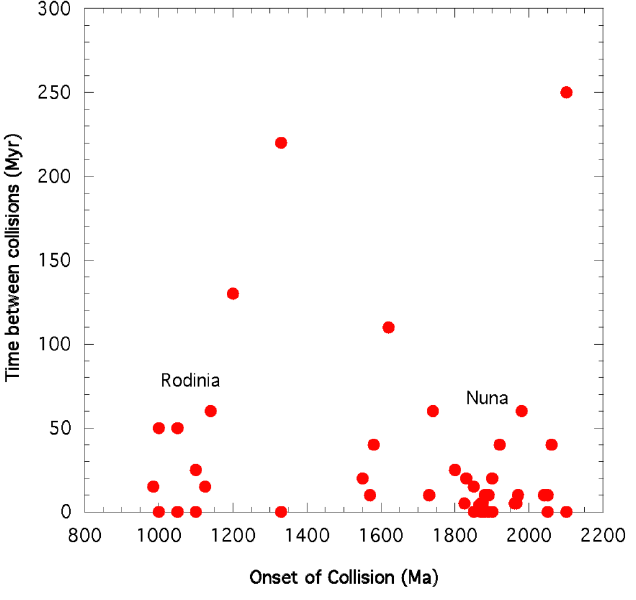
Figure 6. Graph of the time between orogenic collisions and the onset of collision (data from Appendix